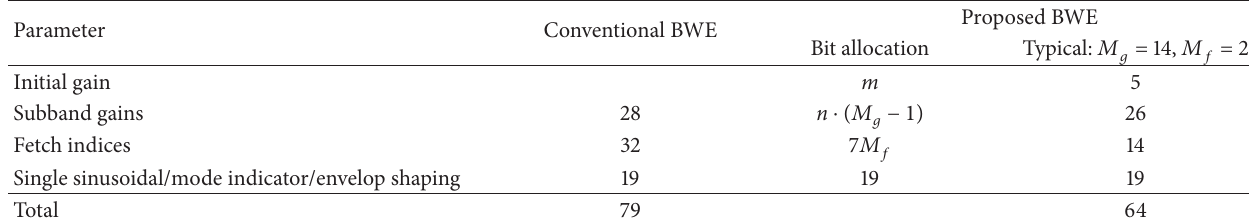
Proposed BWE Bit allocation Typical: 𝑀 𝑔 = 14, 𝑀 𝑓 = 2